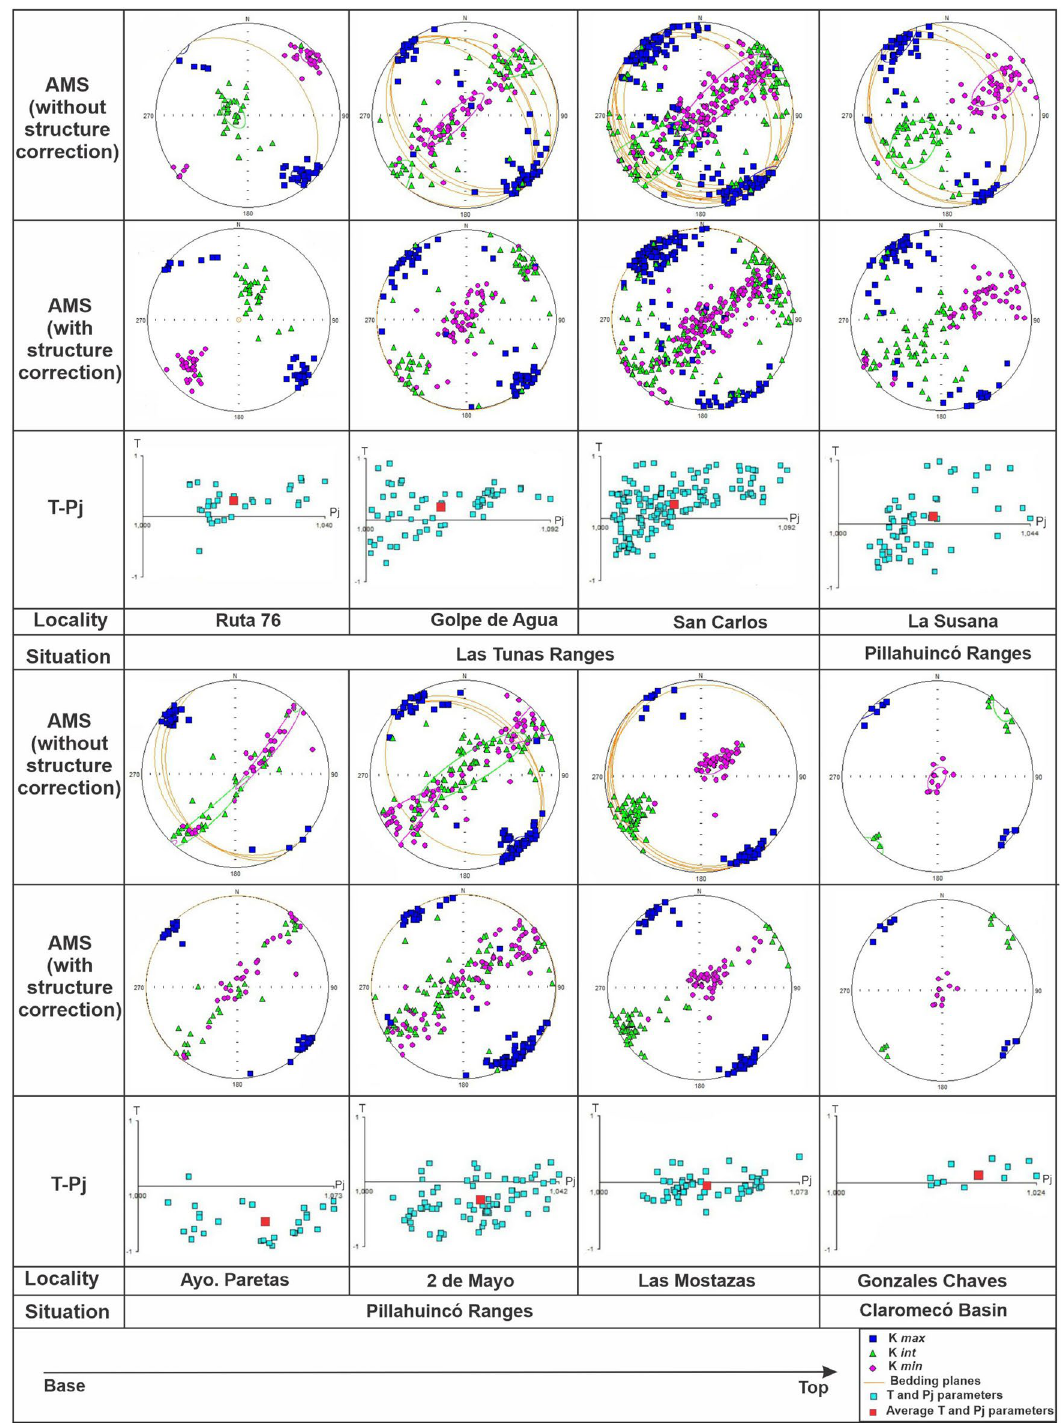
Figure 7. AMS data, with its confidence ellipses 61 , of the different localities of the Tunas Formation situated in Las Tunas Ranges, Pillahuincó Ranges and Claromecó Basin (Fig. 1), from de base to the top: AMS ellipsoids with structural correction, setting the bedding planes in the horizontal position, and ratio between the degree of anisotropy (P j ) and the shape parameter (T), with the average values in red 30,31 , data processed with the Anisoft 4.2